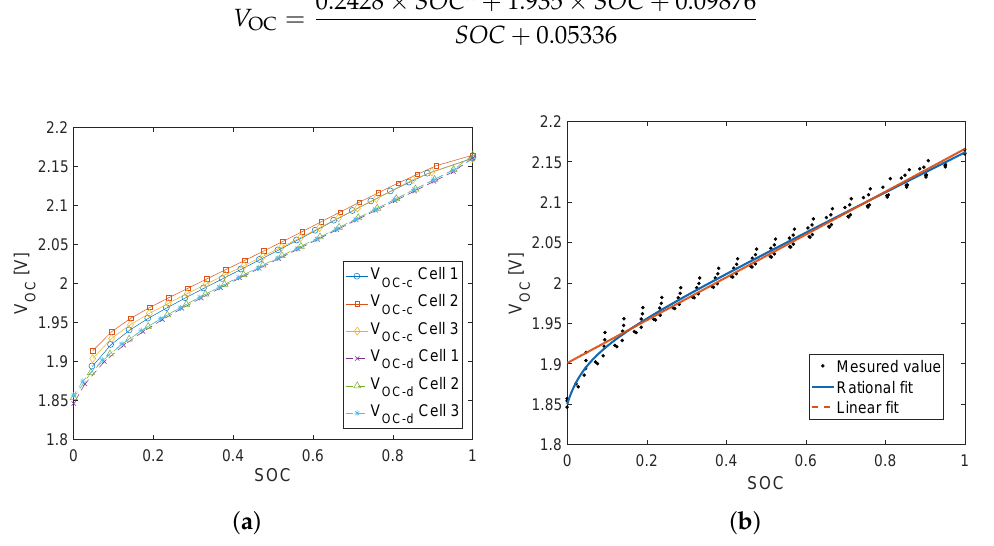
Figure 5. Measured open circuit voltage versus SOC of VRLA battery: ( a ) V OC measured during charge and discharge separately; and ( b ) the measured data points and the fitted